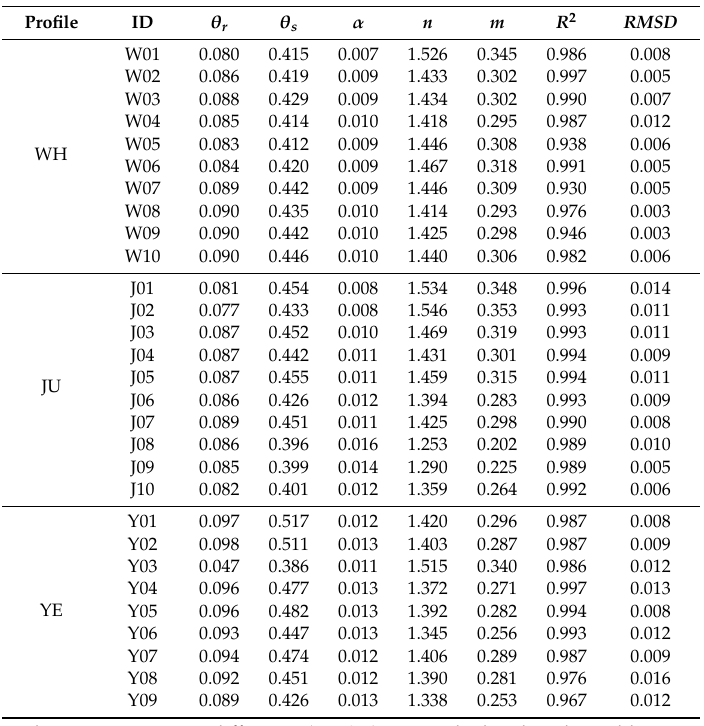
Table 3. The fitted parameters and fitting accuracy of SWRC